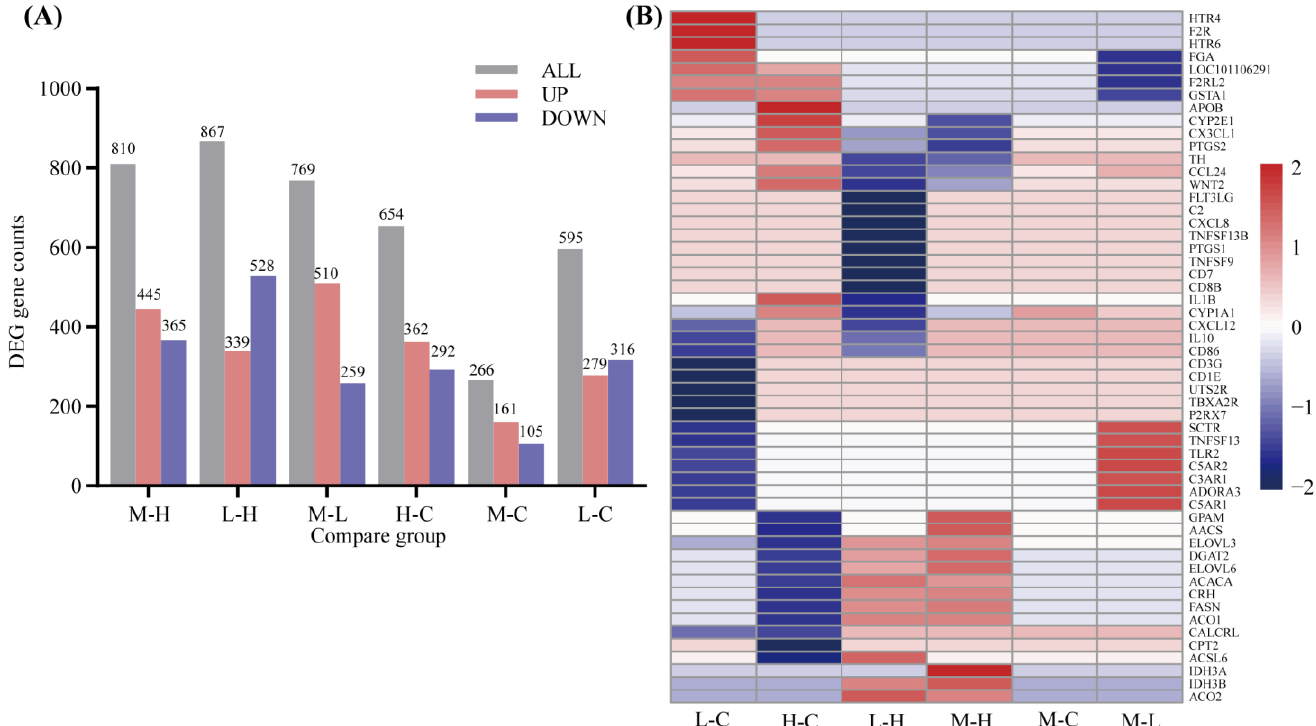
Figure 2. Transcriptome differentially expressed genes (DEGs) expression and clustering in Tan lambs. ( A ) Histogram of DEGs expression among different comparison groups. Pink represents up-regulated DEGs, blue-violet represents down-regulated DEGs. ( B ) Heatmap generated from DEGs and candidate genes using the hierarchical clustering (Pearson-distance-clustering algorithm) features in the R. C, control; L, 10% Agriophyllum squarrosum diet; M, 20% A. squarrosum diet; H, 30% A. squarrosum diet.